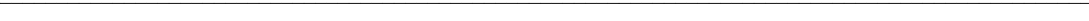
Fig. 6. A(cid:150)D , Rhytidorhachis ? sp.; Llandovery, mid-late Aeronian, Niur Formation, sample S14, Derenjal Mountains; NMW 2011.11G.2, conjoined valves, dorsal, ventral, lateral and anterior views. E (cid:150) J , Hercotrema sp.; Llandovery, mid-late Aeronian, Niur Formation, sample S14, Derenjal Mountains; E(cid:150)H, NMW 2011.11G.3, conjoined valves, dorsal, ventral, lateral and anterior views; I, J, shell fragment showing cardinalia in ventral valve, tooth and vestigial dental plate in dorsal valve. K (cid:150) M , Stegerhynchus sp.?; Llandovery, mid-late Aeronian, Niur Formation, sample S14, Derenjal Mountains; NMW 2011.11G.372, conjoined valves dorsal, ventral and lateral views. N(cid:150)Q , Clorinda sp.; Llandovery, mid-late Aeronian, Niur Formation, sample K25, Boghu Mountains; NMW 2011.11G.1, conjoined valves, ventral, dorsal, lateral and anterior views. R(cid:150)T , Striispirifer ? ocissimus sp. nov.; Llandovery, mid-late Aeronian, Niur Formation sample S14, Derenjal Mountains; R, NMW 2011.11G.362, enlarged dorsal valve interior showing cardinalia; S, T, NMW 2011.11G.366, enlarged ventral valve surface showing microornament. All scale bars except I, J and R(cid:150)T are 2